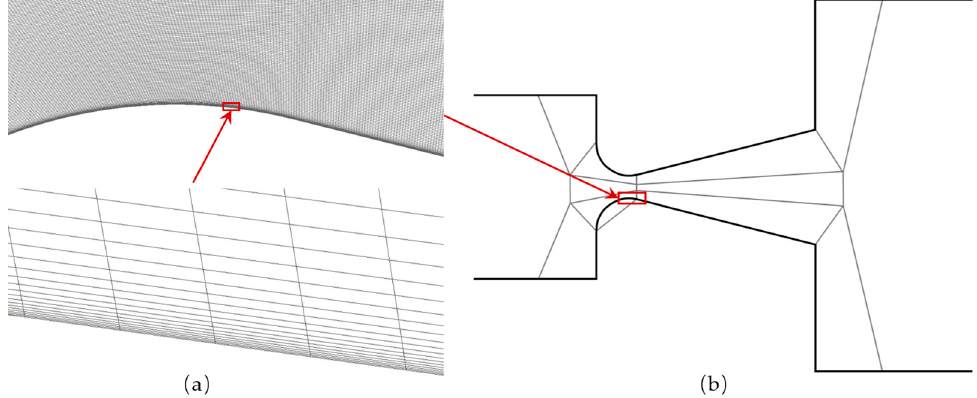
Figure 3. Calculation grids. ( a ) Local grid refinements near the edge of the diffuser throat; ( b ) Topology of the mesh.